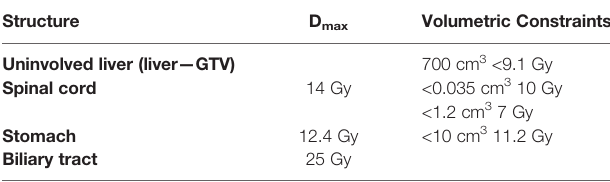
TABLE 1 | Organs at risk